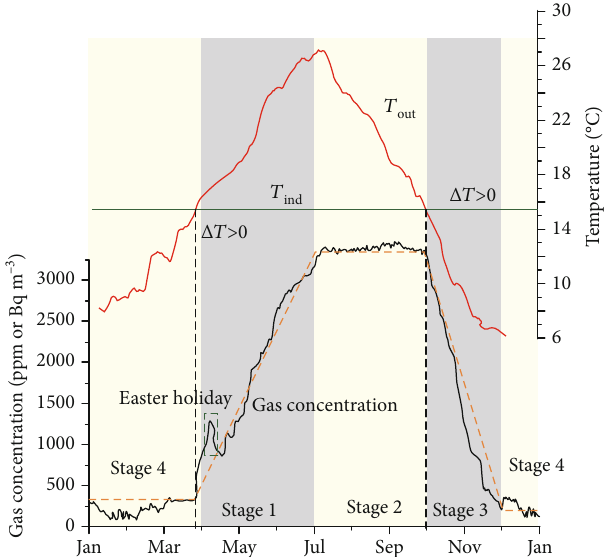
Figure 1: Delimitation of the di ff erent stages to perform the analysis. Indoor and outdoor temperatures and gas concentration do not represent real values but are an example for